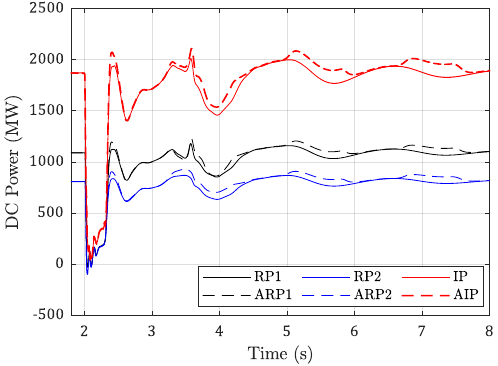
Figure 14. Firing angle in deg.